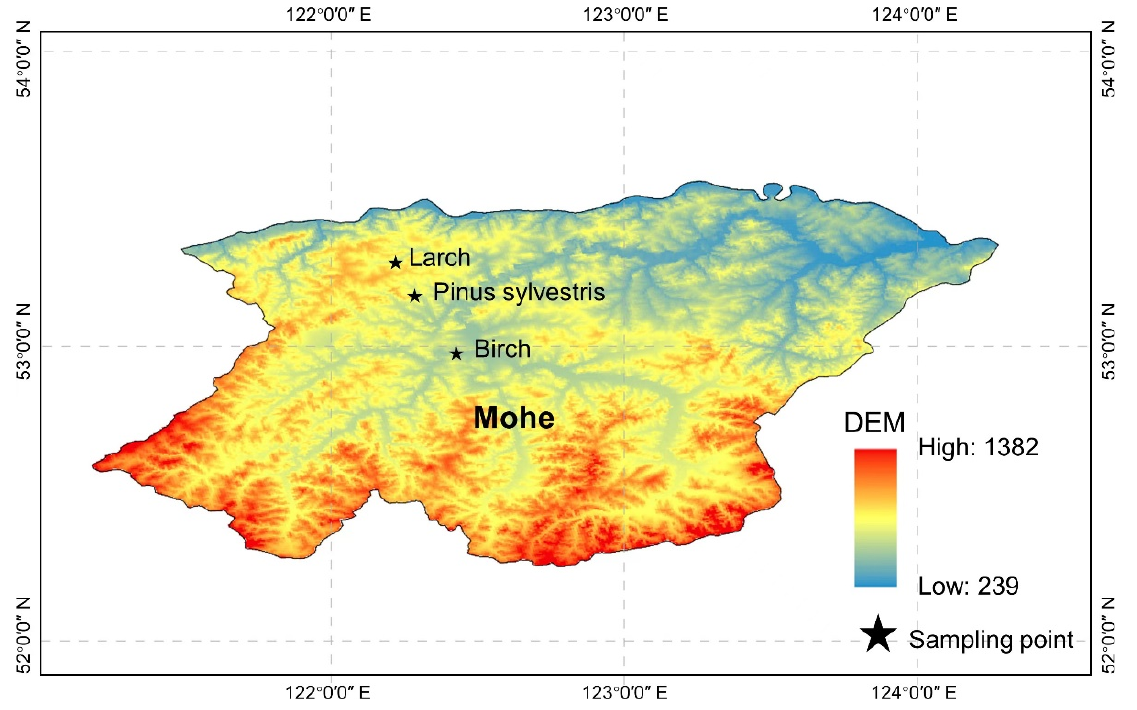
Figure 1. Spot map of the study area.